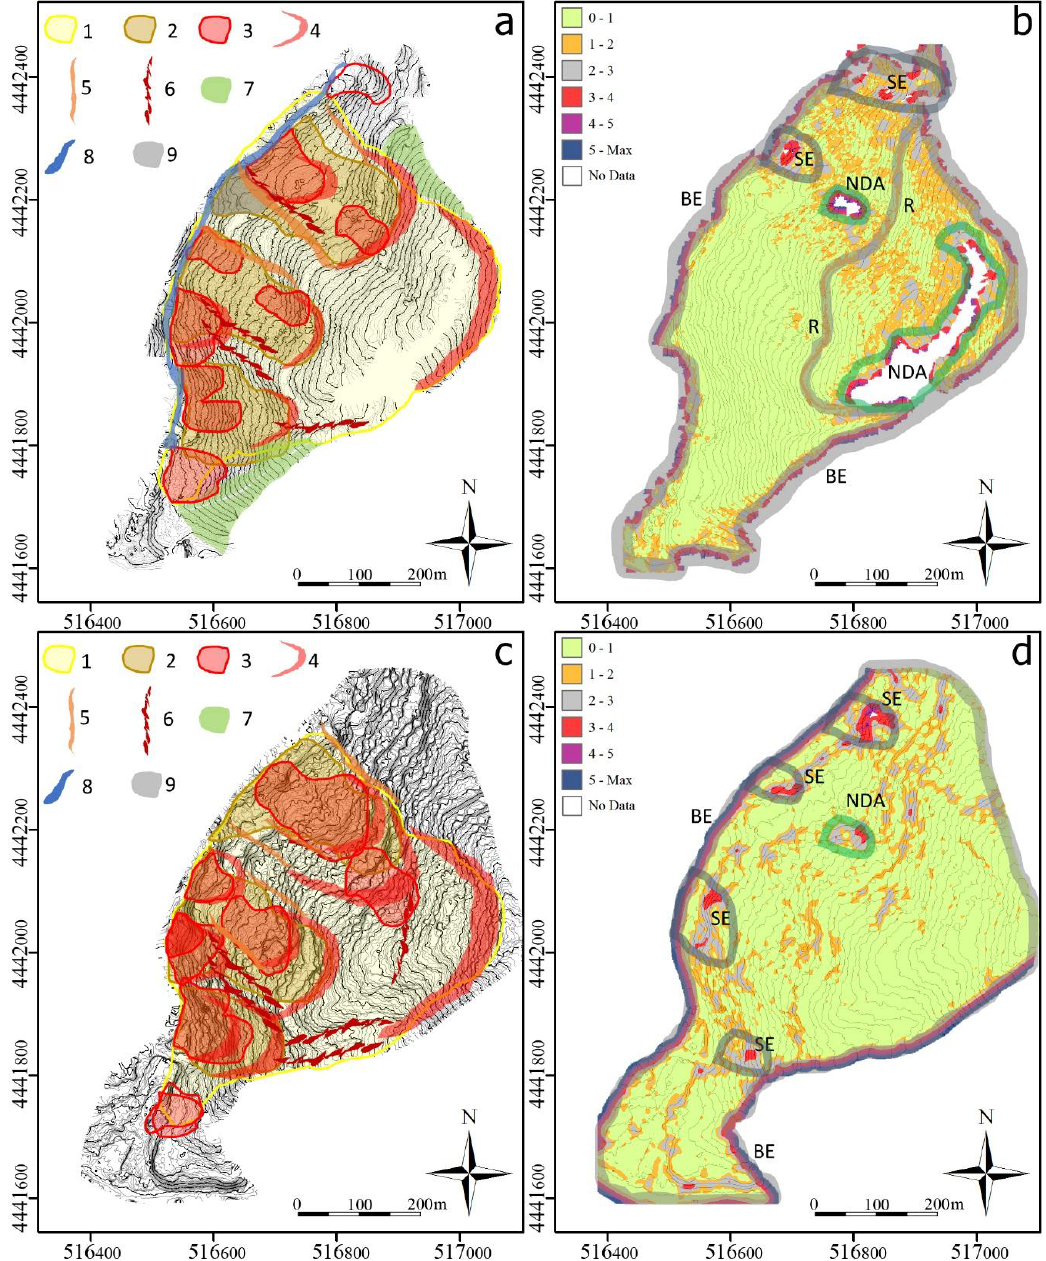
Figure 7. ( a ) Contour map using TLS data; ( b ) relative map of elevation uncertainty, in meters; ( c ) contour map using HRSI; ( d ) relative map of elevation uncertainty, in meters. On the maps in ( a ) and ( c ), an expert-based, full-coverage geomorphological interpretative map is superimposed. Legends in ( a ) and ( c ): 1. landslide system; 2. landslide complex; 3. reactivated single and complex landslide; 4: active or reactivated head scarp; 5. lateral landslide scarp; 6. en-echelon fracture zone; 7. landslide un-affected hillslope; 8. riverbed and bank; 9. landfill. On the maps of elevation uncertainty ( b , d ), coding of the more probable origin of the errors is added. Legends in ( b ) and ( d ): BE = Boundary Effect, NDA = non-instrumentally detected area, SE = shadow effect; R = road.